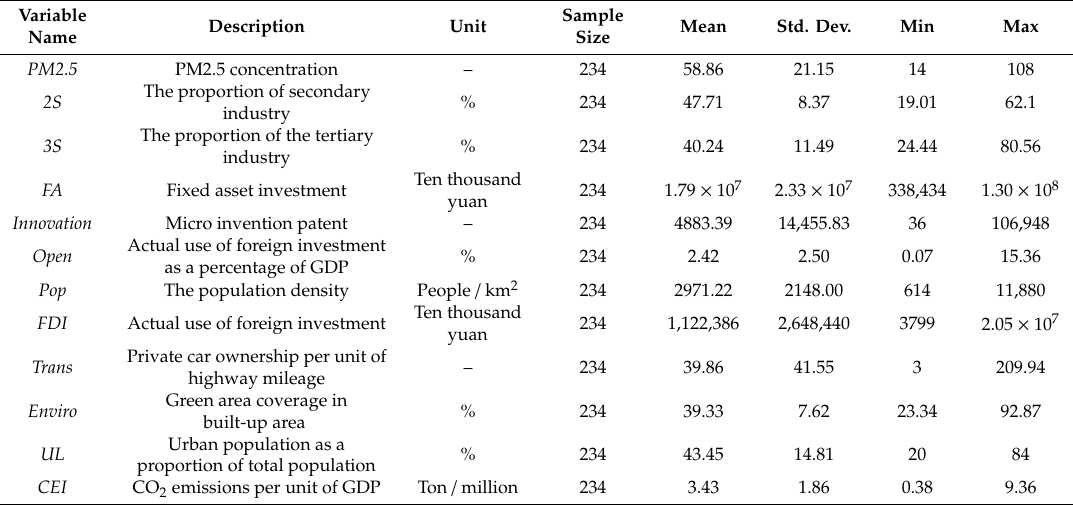
Table 1. Statistical characteristics and units of